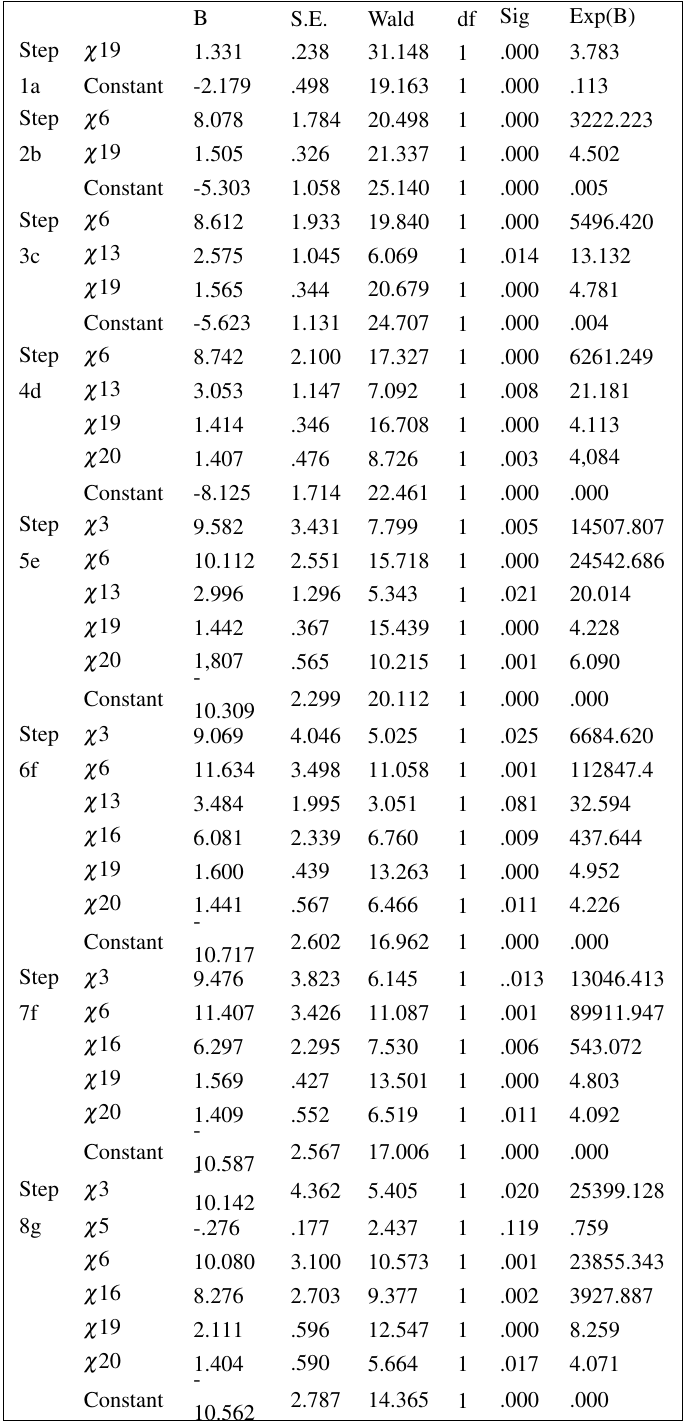
Table 3 Block 1: Method=Forward